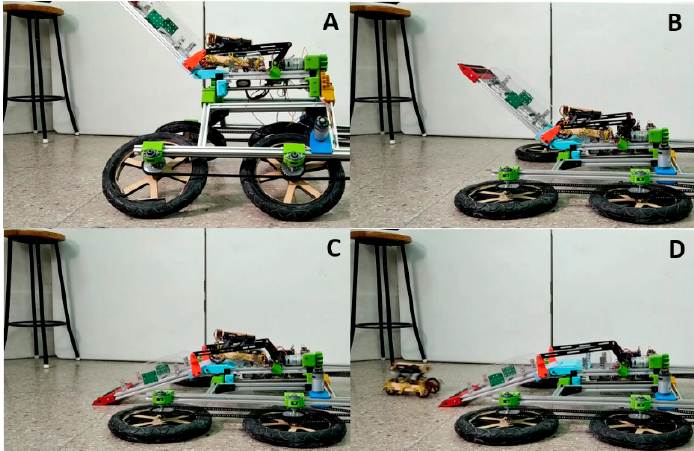
Figure 18. The BSTAR automatically deploying RSTAR (see video in Supplementary Materials).